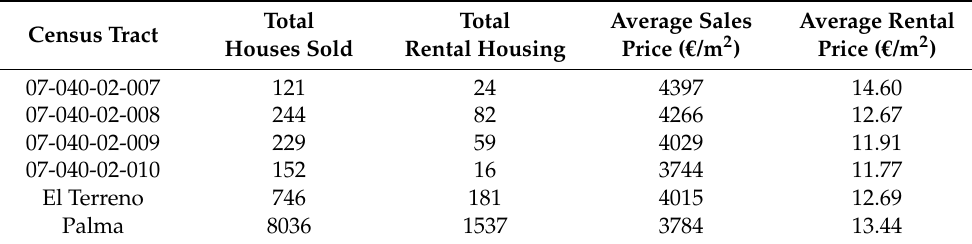
Table 4. Housing for sale and residential rent by census tract in El Terreno (13-03-2020). Source: Own elaboration from El